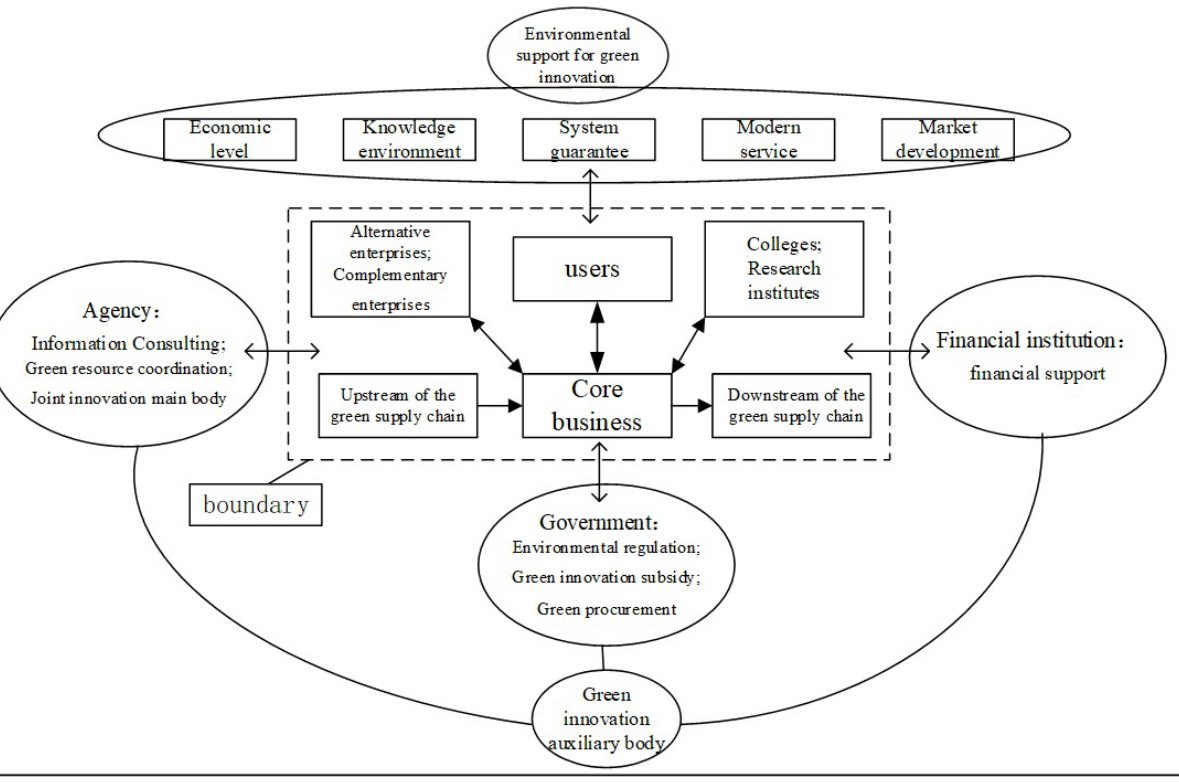
Fig. 1 Schematic diagram of the green innovation